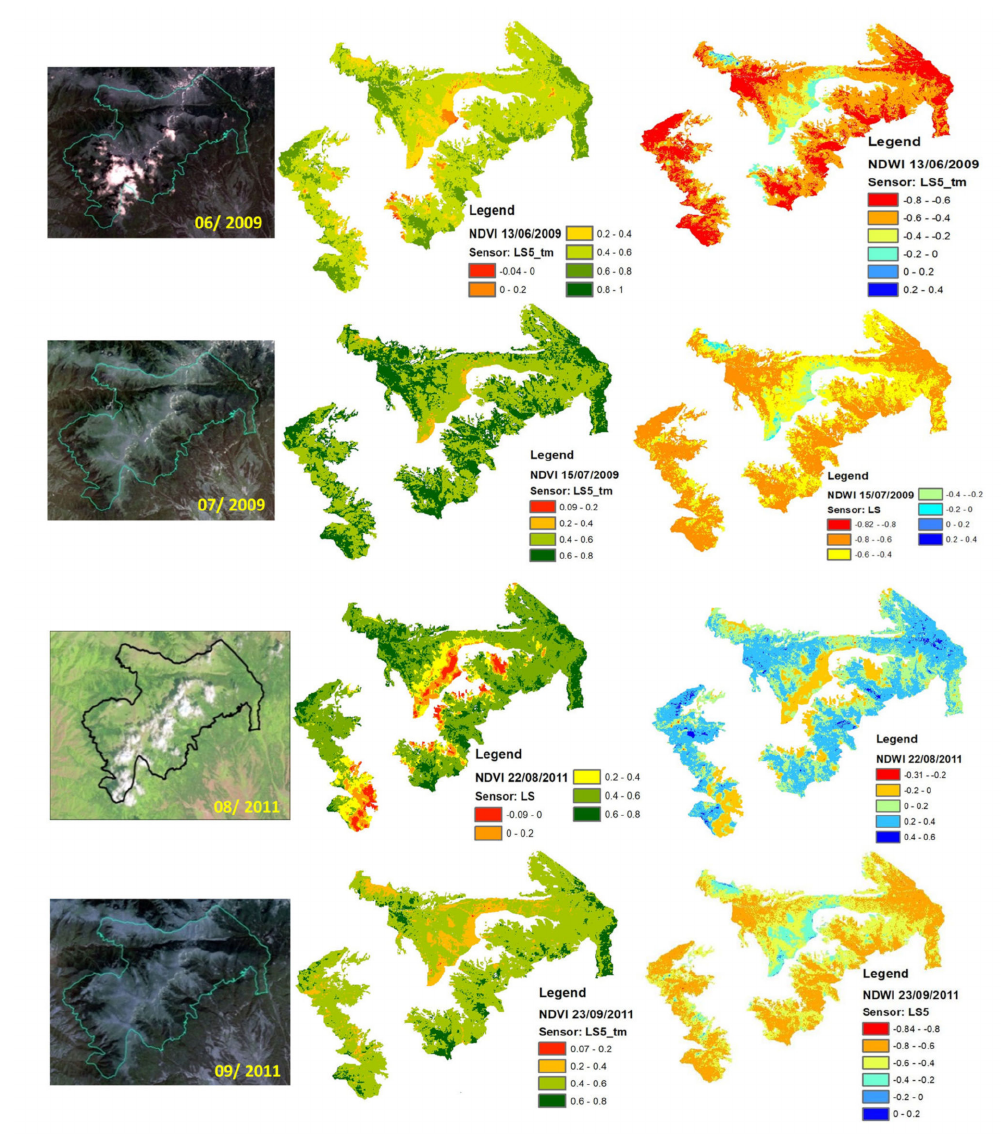
Figure 7. Cross-verification of single satellite images’ time series using different vegetation indices. Anomalies in NDVI and NDWI can help locate the residual clouds in the TM (such is the case over the mountain ridge in the scene from August